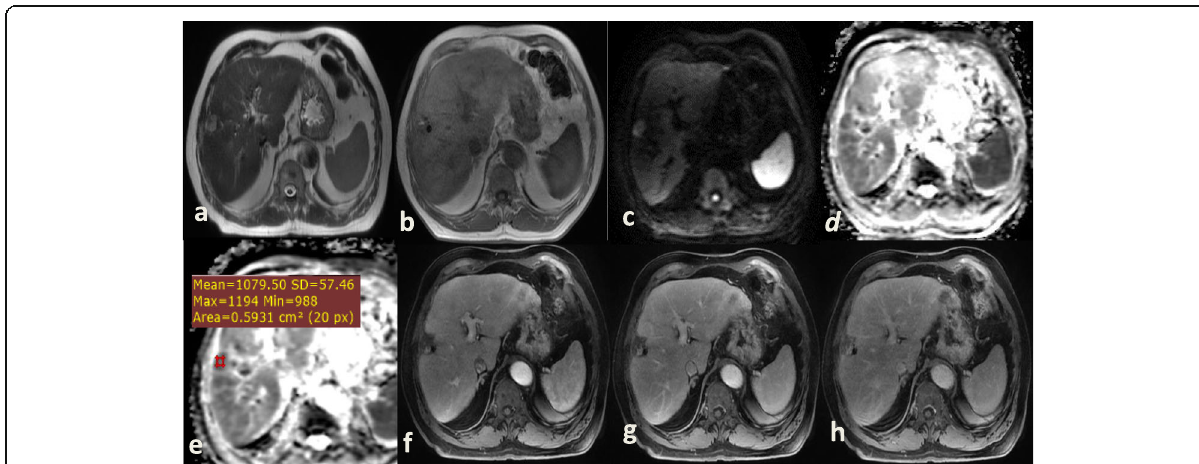
Fig. 2 1st follow-up after 1 month for a 69-year-old male patient having HCC underwent TACE ablation for one focal lesion involving right hepatic lobe segment V. a Heterogeneous signals (predominantly bright) in T2 WIs. b Heterogeneous signals (predominantly iso-intense with hyper-intense and hypo-intense foci) in T1 WIs. c Restricted diffusion in DWI at 800 b value. d Corresponding dark signals in ADC mapping series.